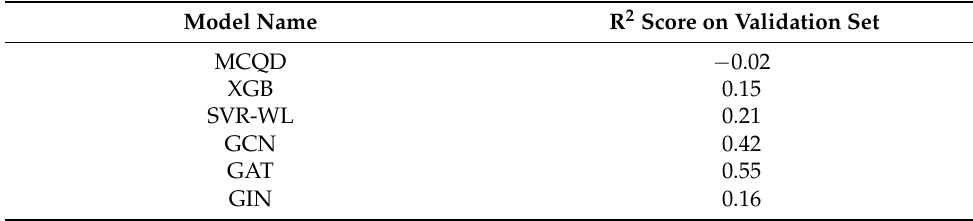
Table 2. R 2 values from different machine learning models.